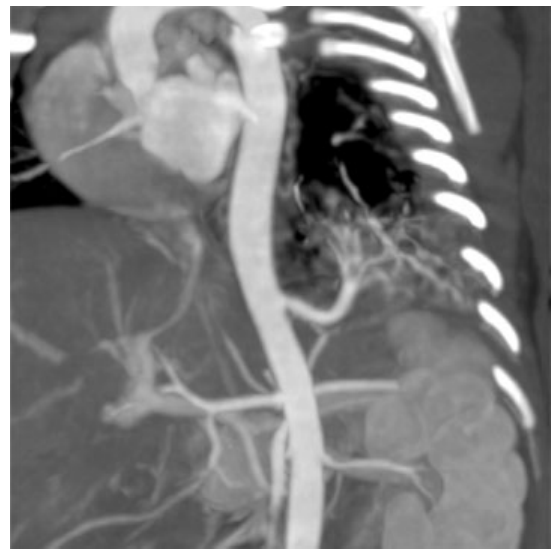
Fig. 1 Postnatal-enhancedcomputedtomographyshowingananomalous arterial supply from the descending aorta to the left lower lobe.